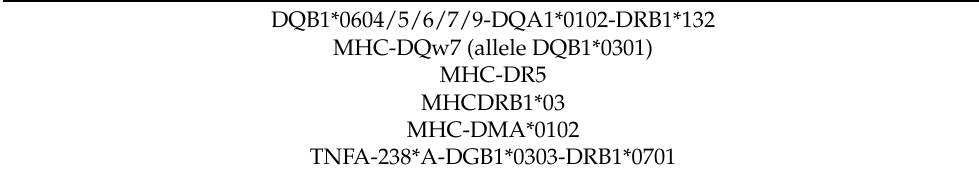
Table 2. Genotypes linked to antiphospholipid syndrome predisposition